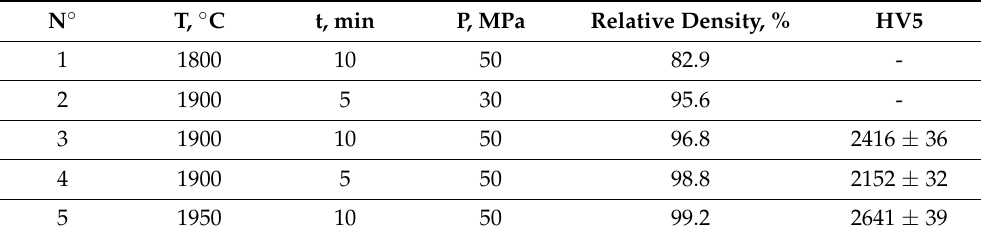
Table 1. Consolidation conditions and properties of bulk boron